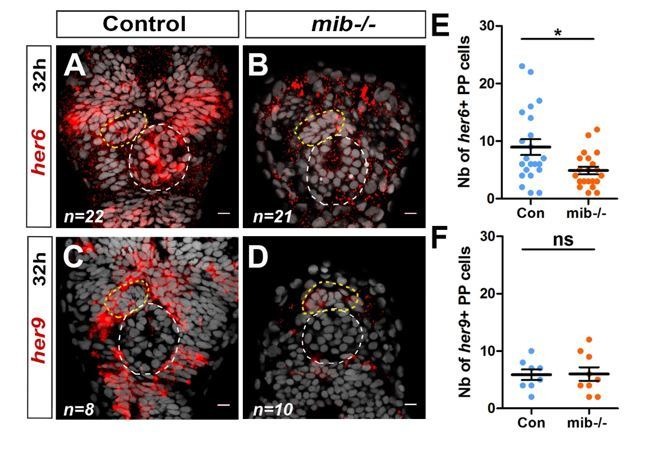
Notch target genes her6 and her9 are mosaïcally expressed in parapineal cells.(A-D) Confocal sections showing the expression of her6 (A, B) and her9 (C, D) (red) at 32 hpf in control embryos (A, C) and in mib-/- mutant embryos (B, D) merged with a cell nuclei staining (grey). (E-F) Dot plots showing the number of her6 (E) and her9 (F) in control (Blue marks) and mib-/- mutant embryos (Orange marks). Embryo view is dorsal, anterior is up; epiphysis (white circle), parapineal gland (yellow circle); scale bar=10 µm. Mean ± SEM are indicated as long and short bars. ** P-value<0.01; * P-value<0.05 in welsh t test (Wilcoxon test); data corresponds to one experiment.